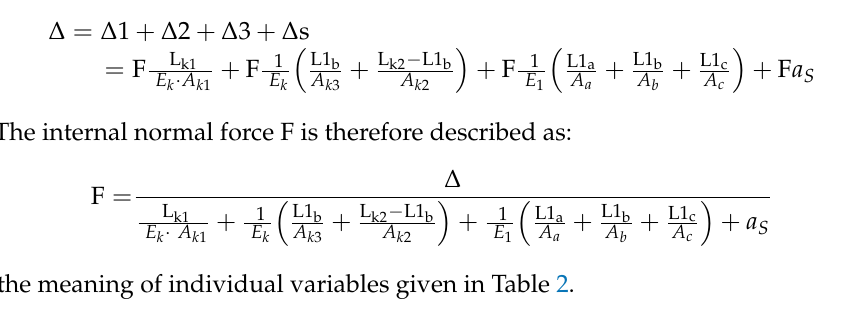
Table 2. Definition of deterministic input